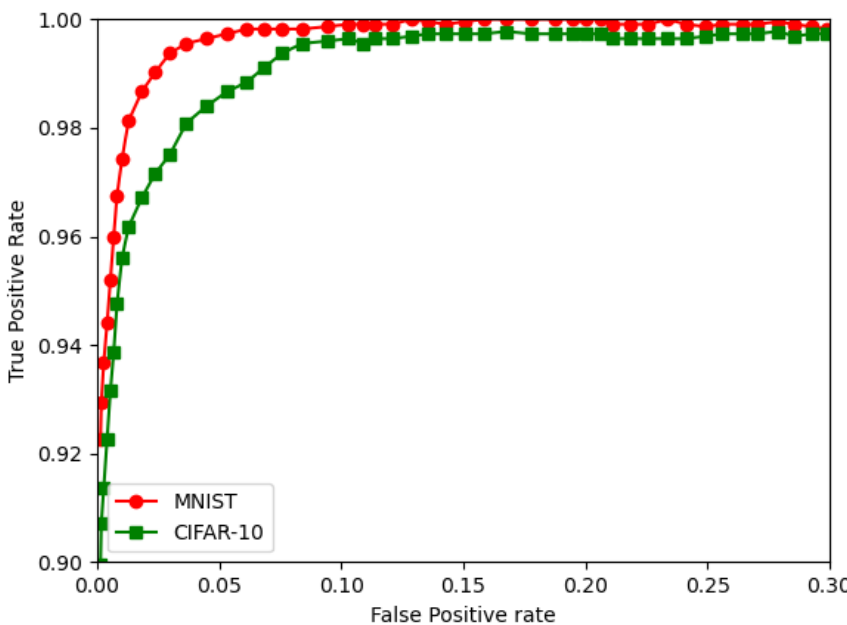
Figure 14. The ROC curves for the CIFAR-10 and the MNIST for the